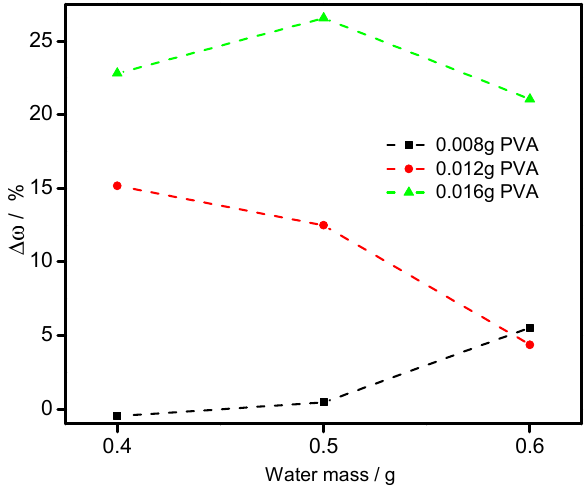
Figure 7. The relationship between ∆ ω and the dosage of water and polyvinyl alcohol (PVA).